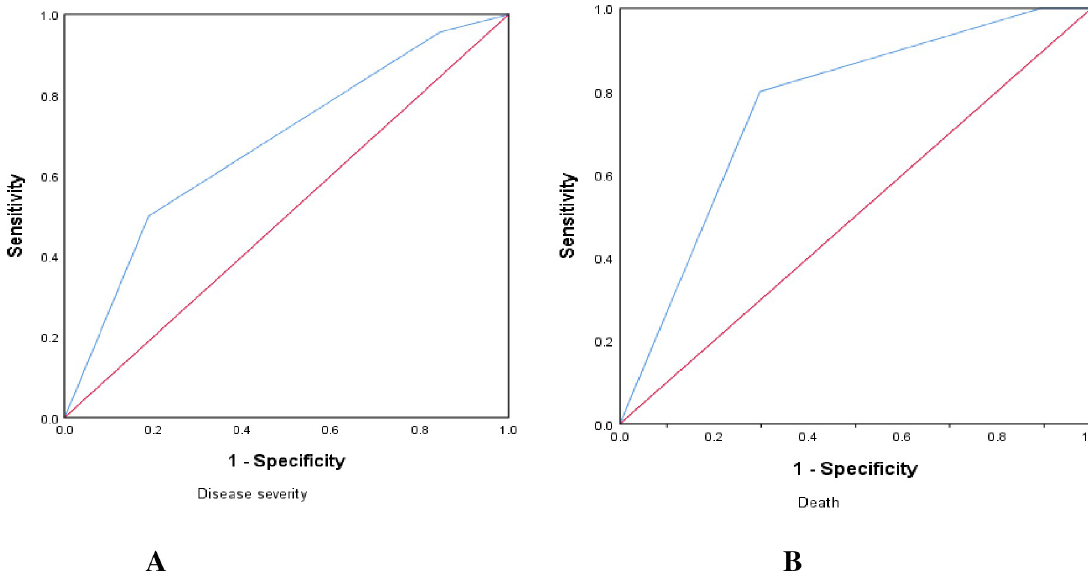
Fig 3. ROC curve analysis to predict creatinine as predictor of disease severity (A) and mortality (B).